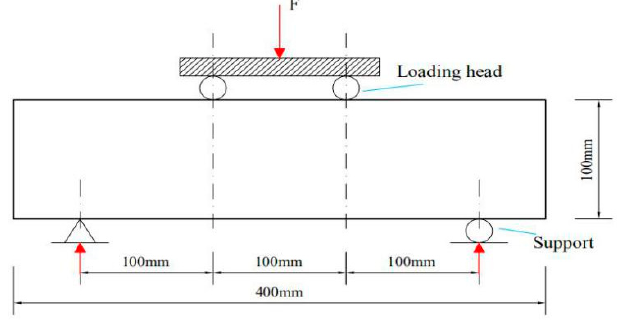
Figure 4. Schematic diagram of flexural resistance test.